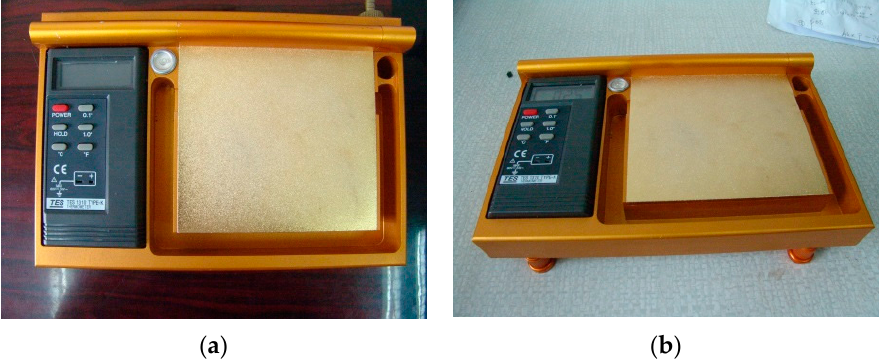
Figure 3. Photos of the diffuse reflecting gilded plate with steady-temperature water troughs.